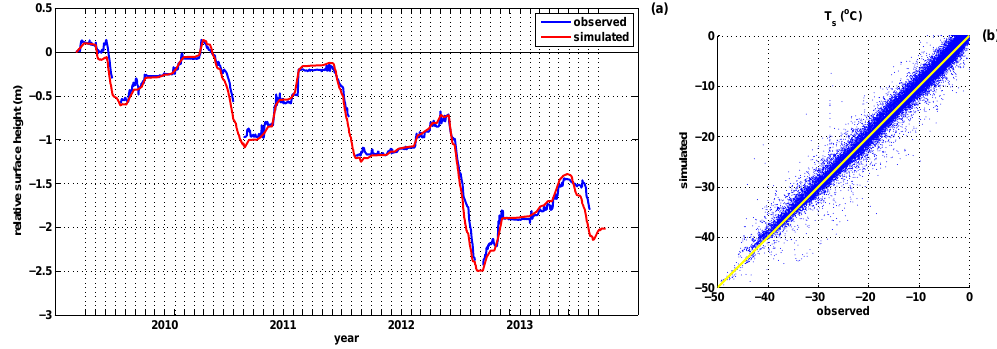
Figure 2. SEB model validation: (a) observed and simulated relative surface height for the period of observations. (b) Simulated against observed T s ( R 2 = 0.98; ( (cid:49)T s ) avg = 0.11 ◦ C; RMSE = 1.43 ◦